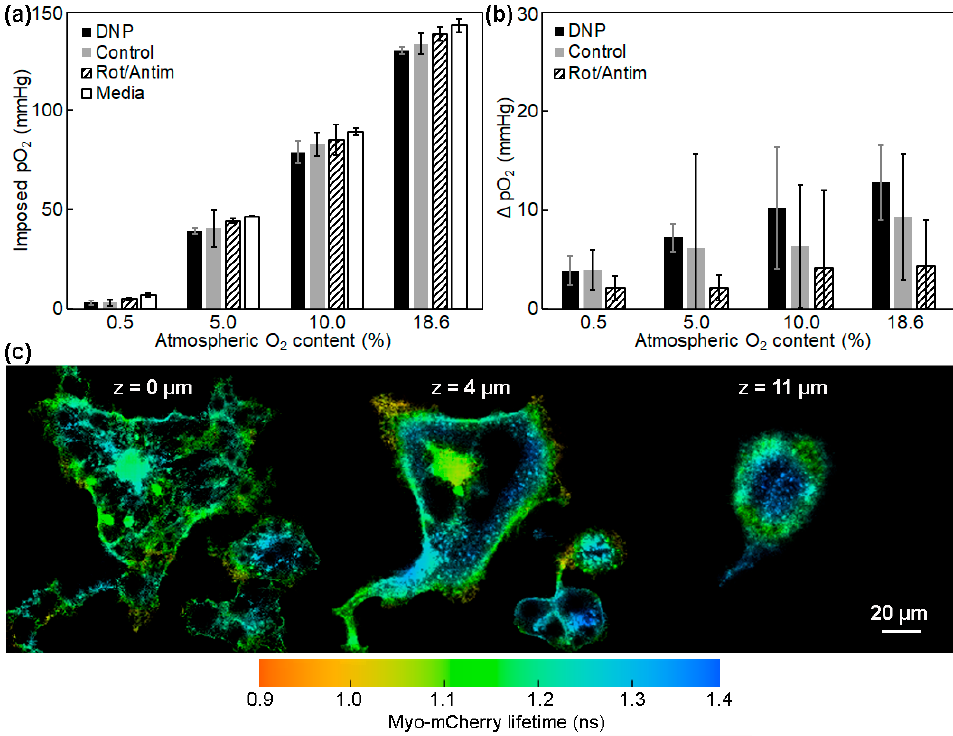
Figure 5. ( a ) The imposed pO 2 measured with OxyLite Pro in culture medium with or without respiring HeLa cells; the x axis represents the applied atmospheric O 2 % in the stage incubator. ( b ) Change in O 2 concentration ( ∆ pO 2 ) measured with the OxyLite as a function of cellular respiration and applied pO 2 , relative to values obtained for the medium (without cells). The error bars in ( a ) and ( b ) are the standard deviations. ( c ) Pseudocolor mapping of Myo-mCherry fluorescence lifetime in the plasma membrane of HeLa cells at different heights above the substrate. The cells were exposed to atmospheric [O 2 ] of 18.6%.